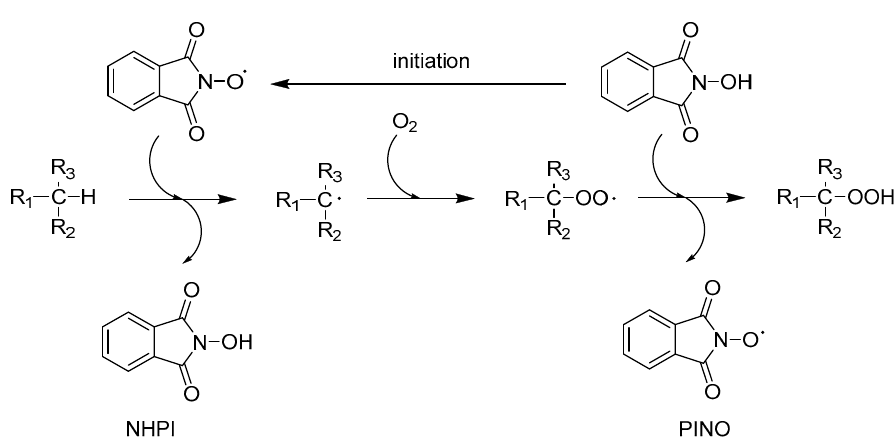
Figure 1. Mechanism of hydrocarbons oxidation using N -hydroxyphthalimide (NHPI).